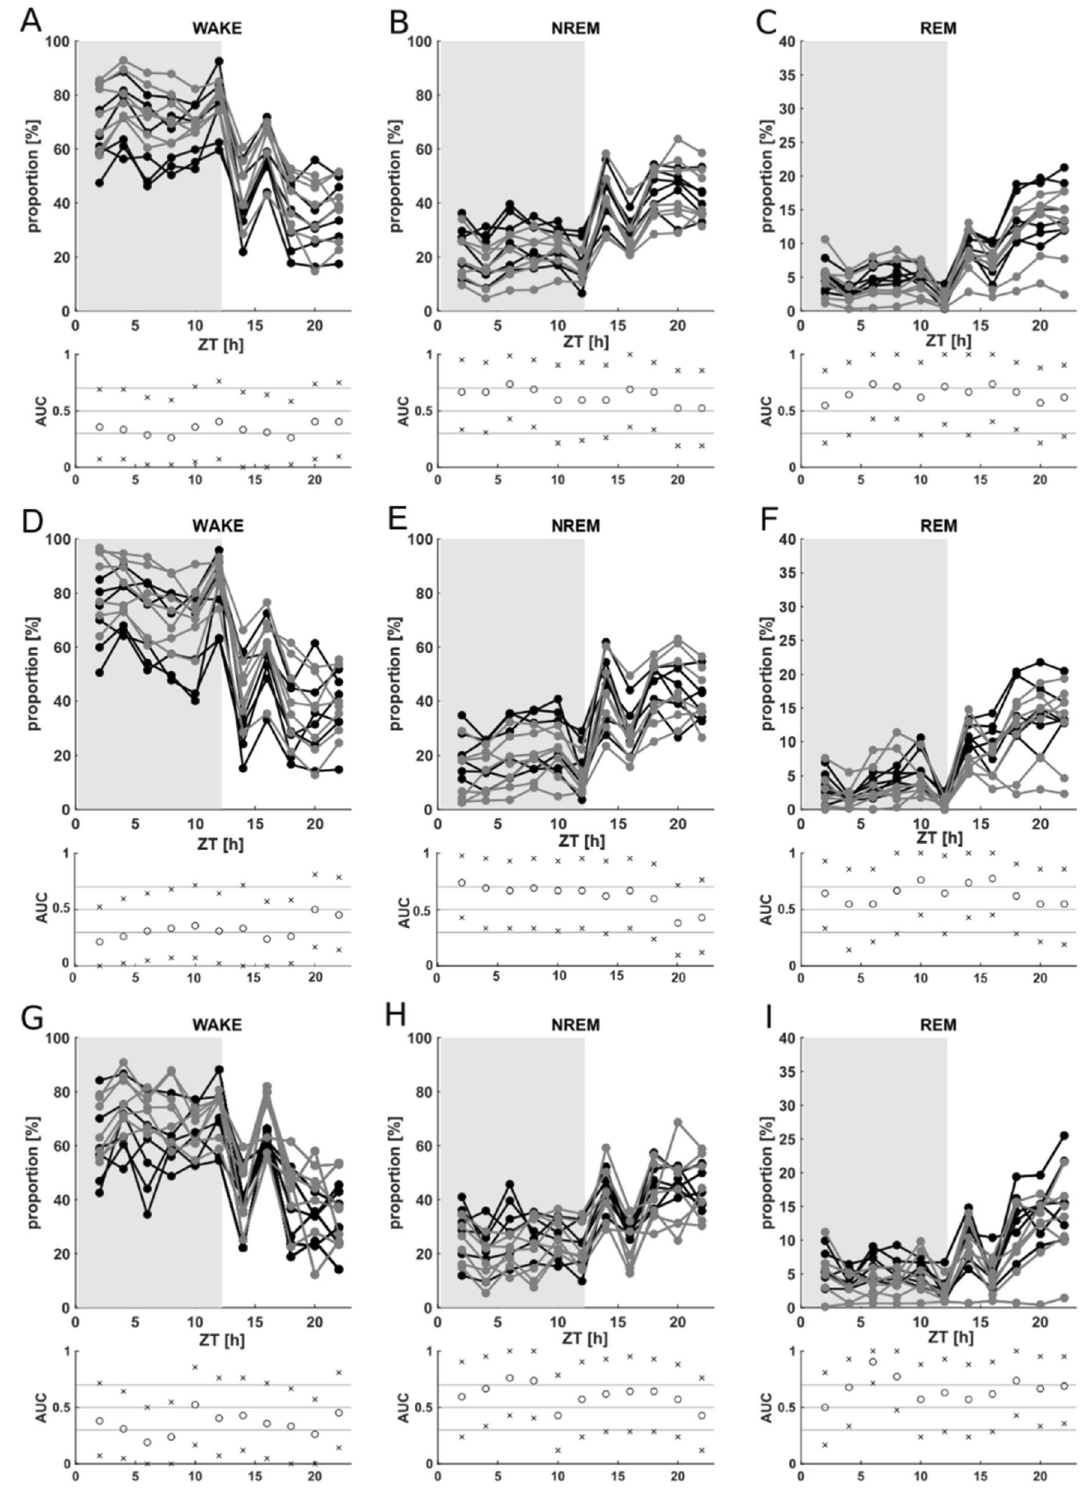
Figure 3. Proportion of the vigilance states of the nontethered (black, n = 6) and tethered (gray, n = 7) animals for nonoverlapping 2 h observation episodes throughout the 22 h. Lights were turned on after 12 h. Gray exhibits the dark phase, white exhibits the light phase. The x-axis represents Zeitgeber time (ZT). Circles represent the calculated AUC. The limits of the 95% confidence intervals are represented by the letter x. NREM: NREM sleep, REM: REM sleep ( A – C ) Averaged values for all 9 days of the experimental observation period for WAKE ( A ), NREM sleep ( B ) and REM sleep ( C ). The AUC analysis detected no effect between the nontethered (black) and tethered (gray) animals. ( D – F ) Averaged values for the first 3 days (early) of the experimental observation period for WAKE ( D ), NREM sleep ( E ) and REM sleep ( F ). The AUC analysis detected no effect between the nontethered (black) and tethered (gray) animals. ( G – I ) Averaged values for the last 3 days (late) of the experimental observation period for WAKE ( G ), NREM sleep ( H ) and REM ( I ) sleep. The AUC analysis detected no effect between the nontethered (black) and tethered (gray) animals. Data are plotted individually for each